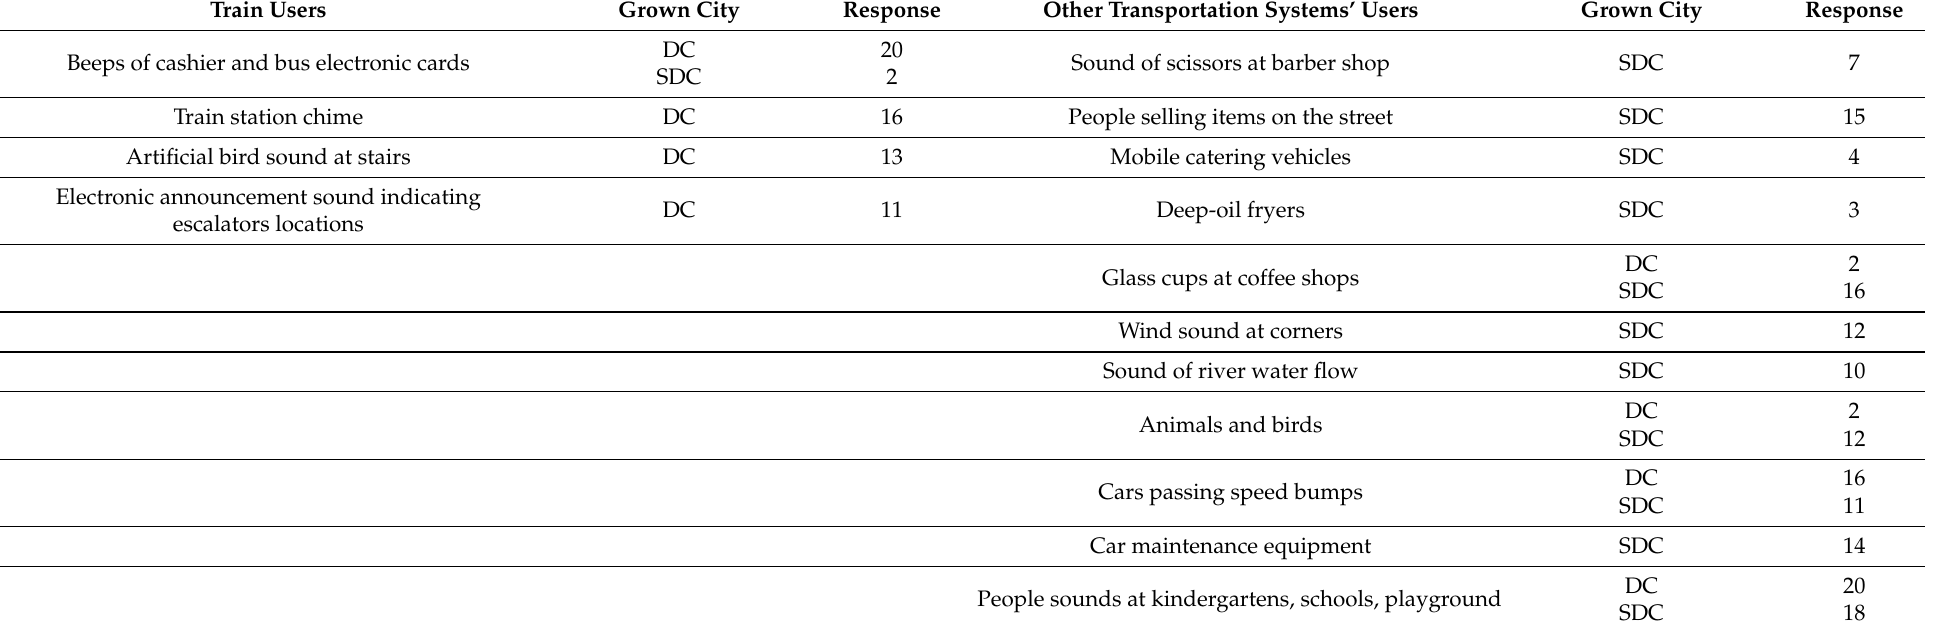
Table 3. Natural and artificial auditory cues as a source of information in unfamiliar